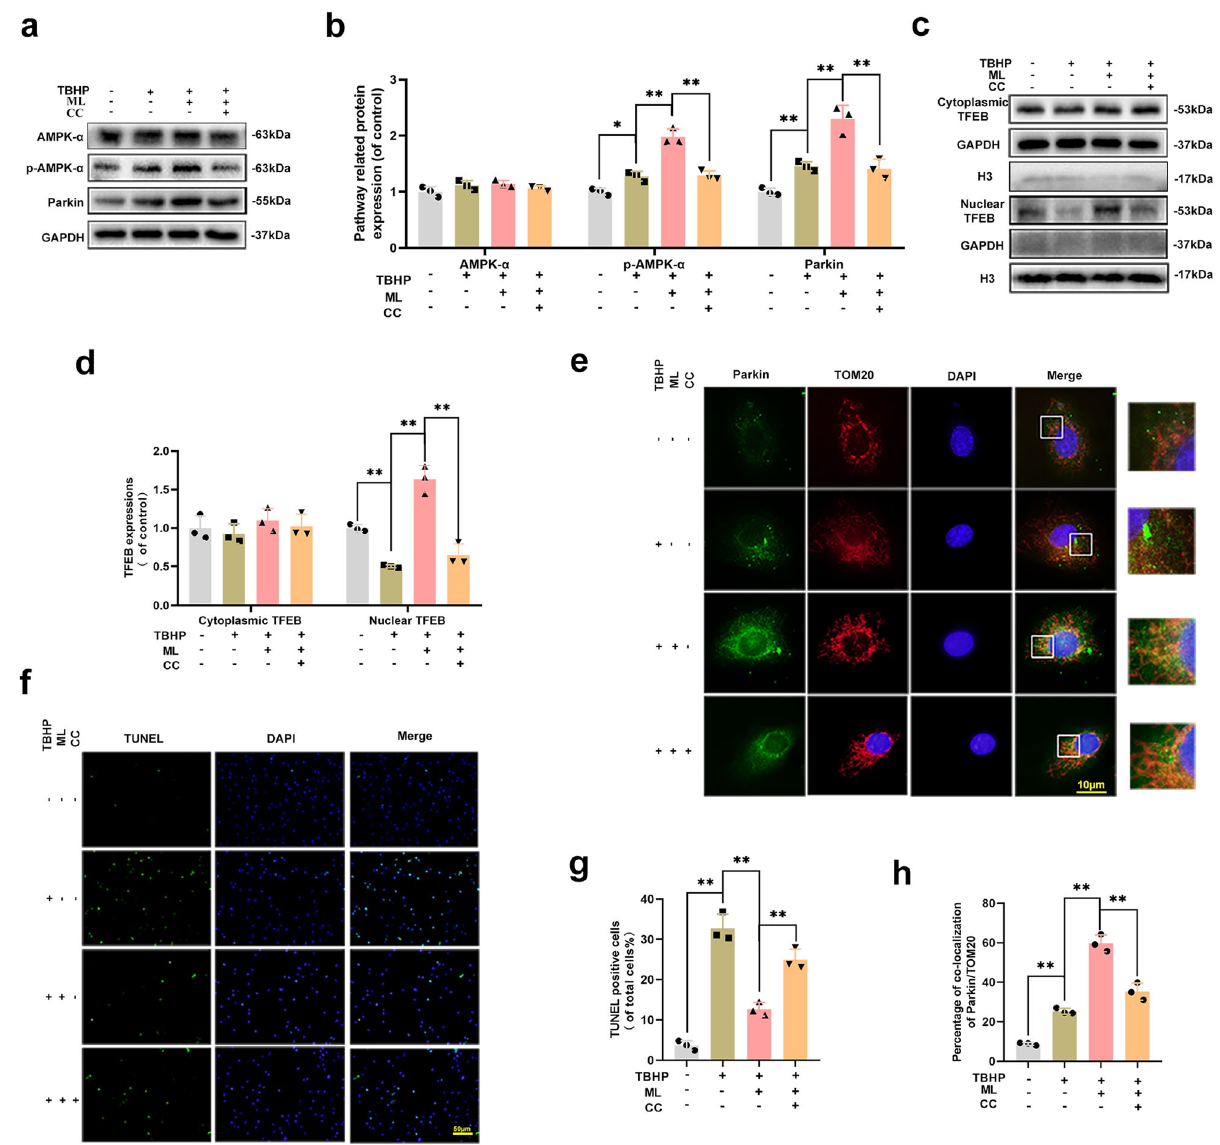
Fig. 6 ML induced mitophagy via AMPK-TFEB signaling pathway in HUVECs. a , b Expression and quanti fi cation of proteins AMPK- α , p-AMPK- α , and Parkin were measured by western blot. c , d Western blots were used to evaluate the level of cytoplasmic and nuclear TFEB in HUVECs. e , h Image of double-labeled staining of Parkin and Tom20 in HUVECs treated as above (Green: Tom20, red: Parkin, bar: 10 μ m). f , g Cell apoptosis was evaluated using TUNEL assay in HUVECs (bar: 50 μ m). All experiments have been performed at least 3 times ( n ≥ 3). Data are presented as mean ± S.D. n = 3, ** P < 0.01, * P <